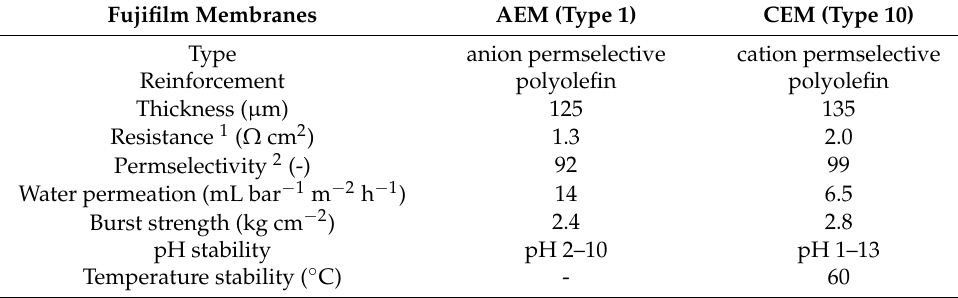
Table 1. Properties of ion-exchange membranes used in reverse electrodialysis